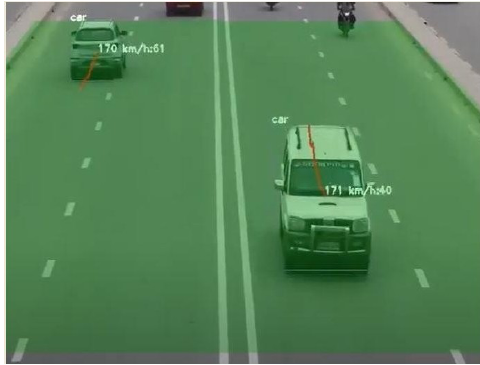
Fig. 6 : Detecting Car Speed under selected area